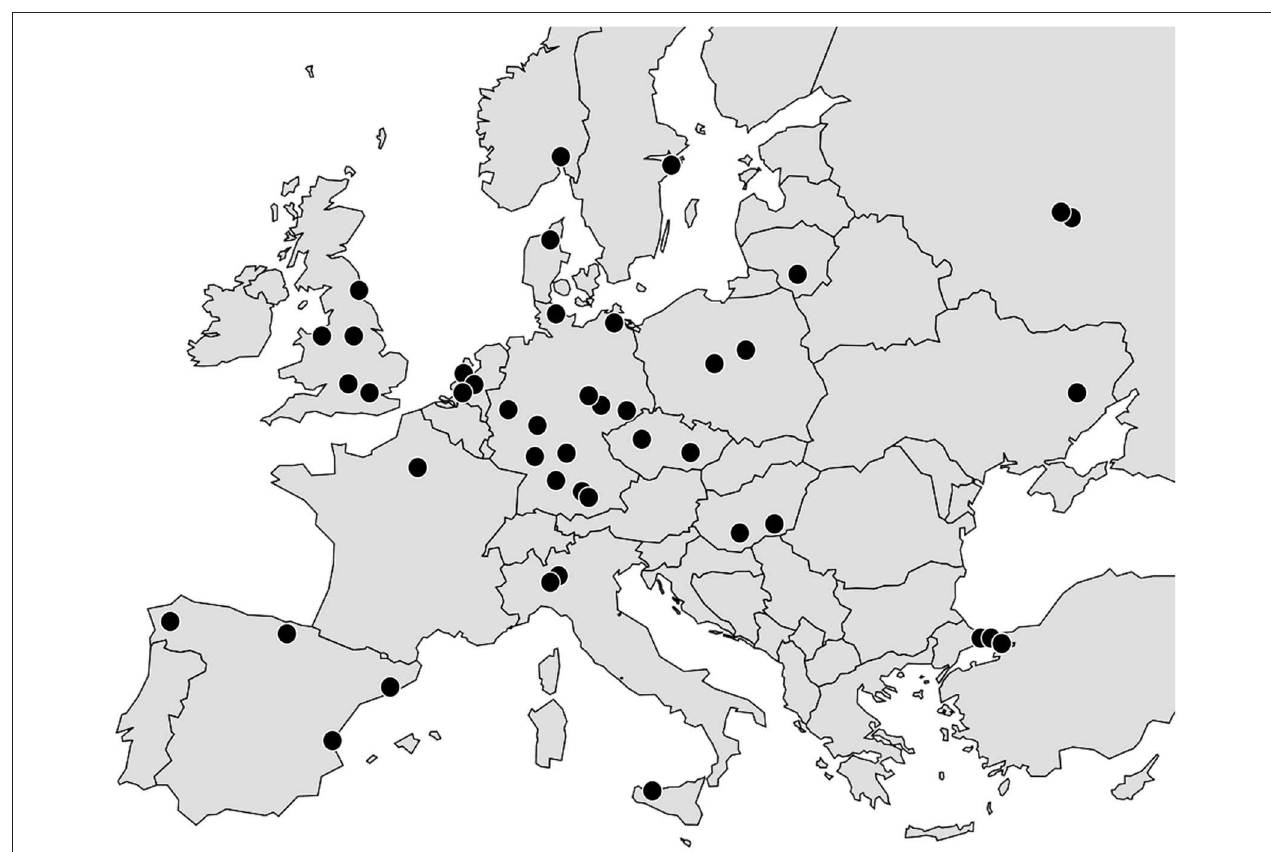
FIGURE 1 | European centers (dots) involved in the PrescrAIP Study.